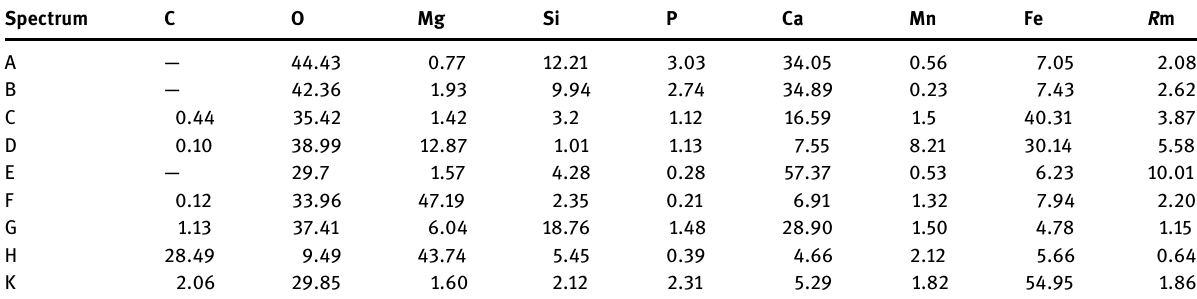
Table 2: The components of di ff erent color regions in the slag sample detected by DES Spectrum